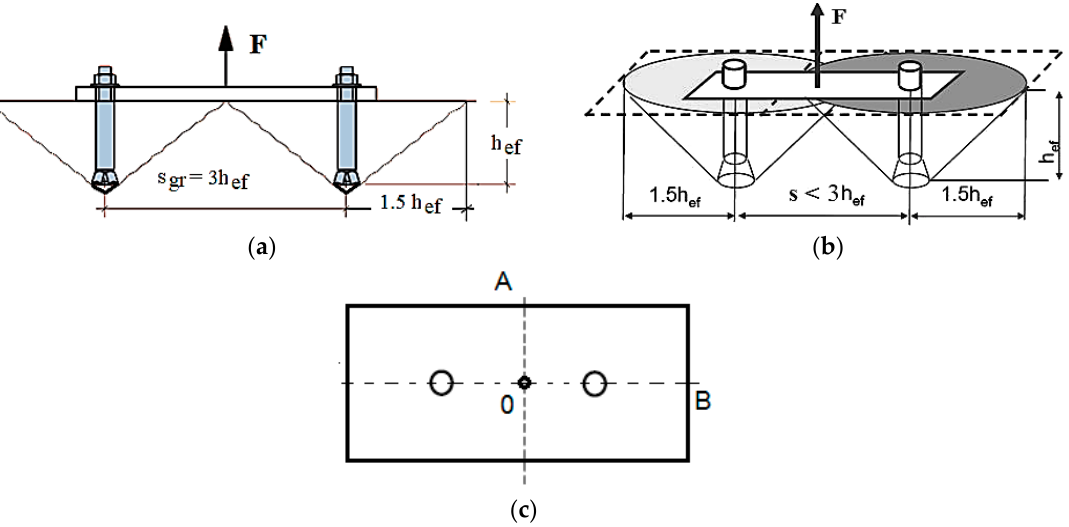
Figure 4. A scheme of a two-anchor system of fasteners: ( a ) the limit distance of the anchors, ( b ) the interaction of the failure cones, ( c ) the impact model quarter of 2 anchors analyzed.